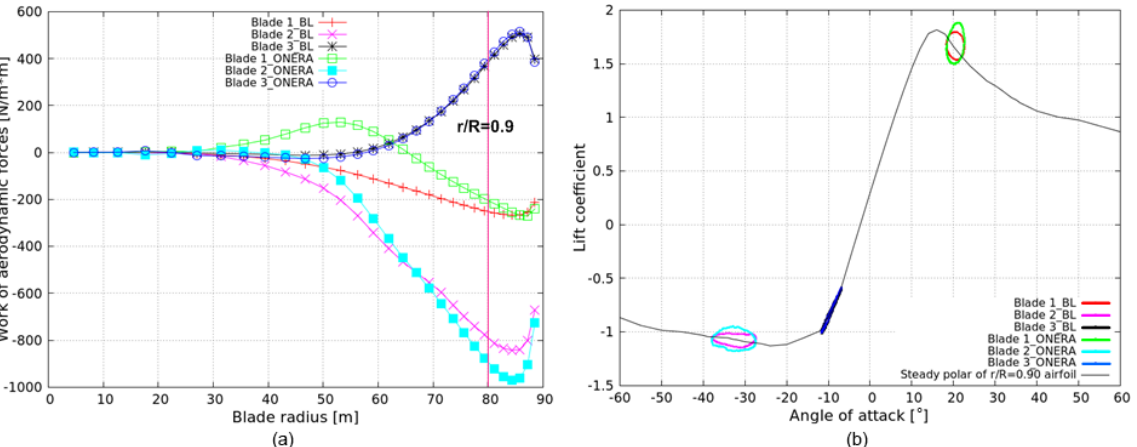
Figure 28. (a) Distribution of aerodynamic work over the three blades for mode M7. Azimuth angle 20 ◦ . (b) C L –AOA loops of the three blades at r/R = 0 . 90 for mode M7. Azimuth angle 20 ◦ .